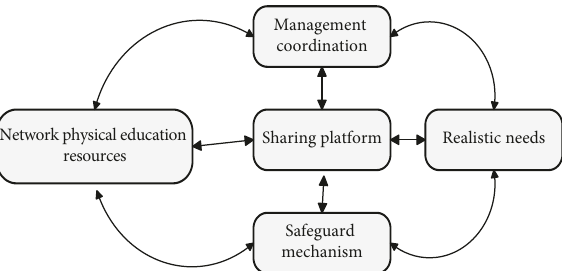
Figure 1: Elements of the operation system of regional university sports network education resource